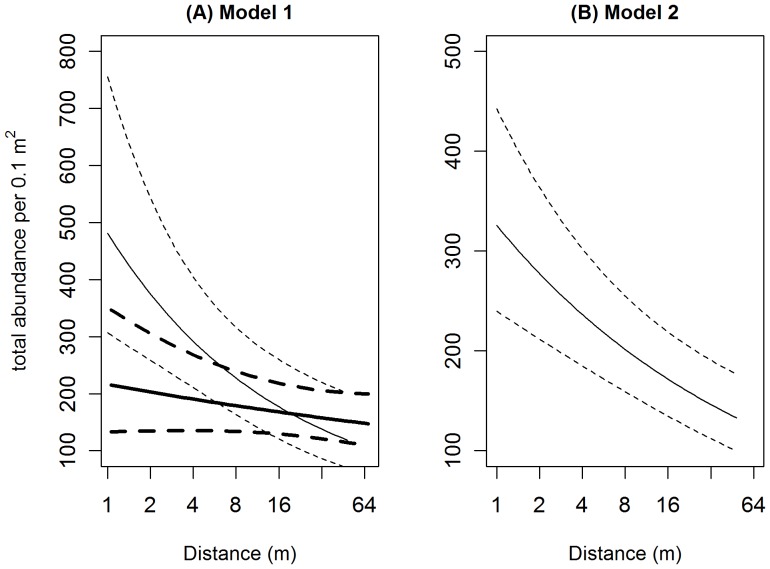
Total macrofaunal abundance predictions from alternative models.(A) Model 1: relationship between total faunal abundance and Distance (log2 scale) at 1000 g per hash per grab (light lines) and 50 g hash per grab (heavy lines) respectively. Model 2 (B) total abundance as a function of distance. The total abundance has been back transformed from the loge scale used in the model. For both models, the solid line indicates the model predictions with 95% confidence intervals shown as dashed lines.